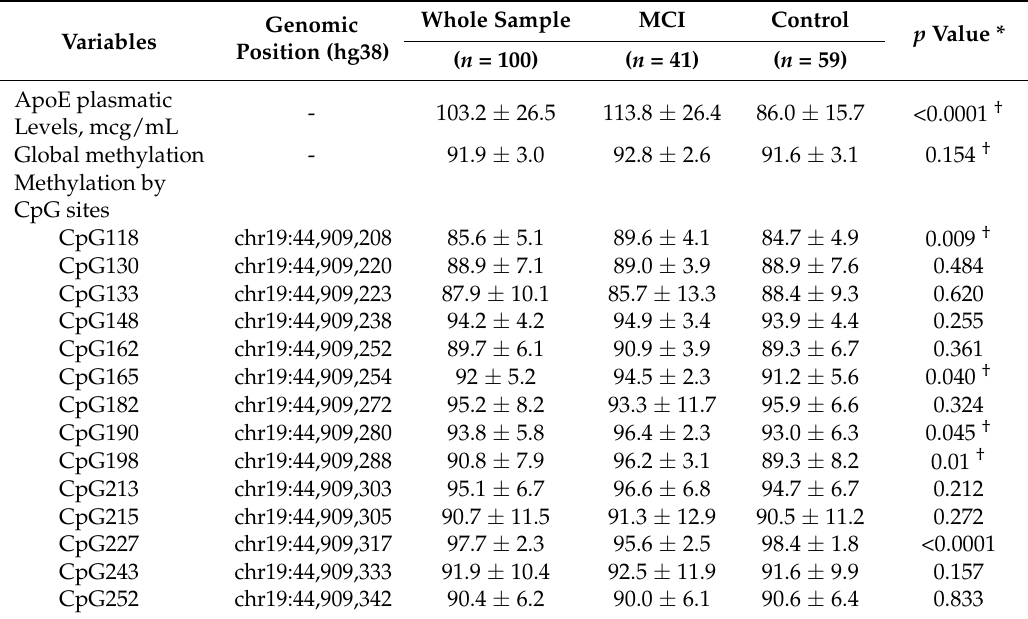
Table 2. Results of ApoE plasma levels and APOE methylation of CpGs sites and comparison between individuals with mild cognitive impairment and normal controls.